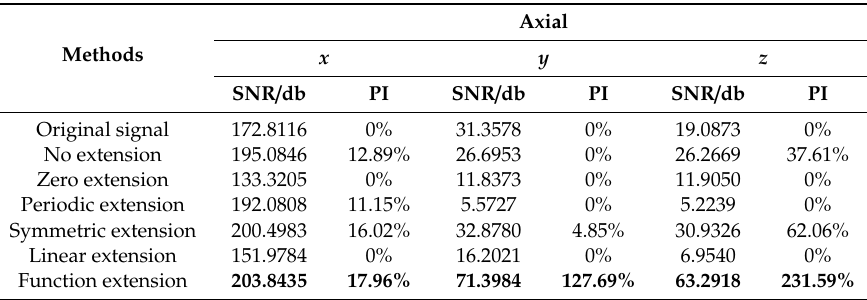
Table 2. SNR and PI results of different extension methods.